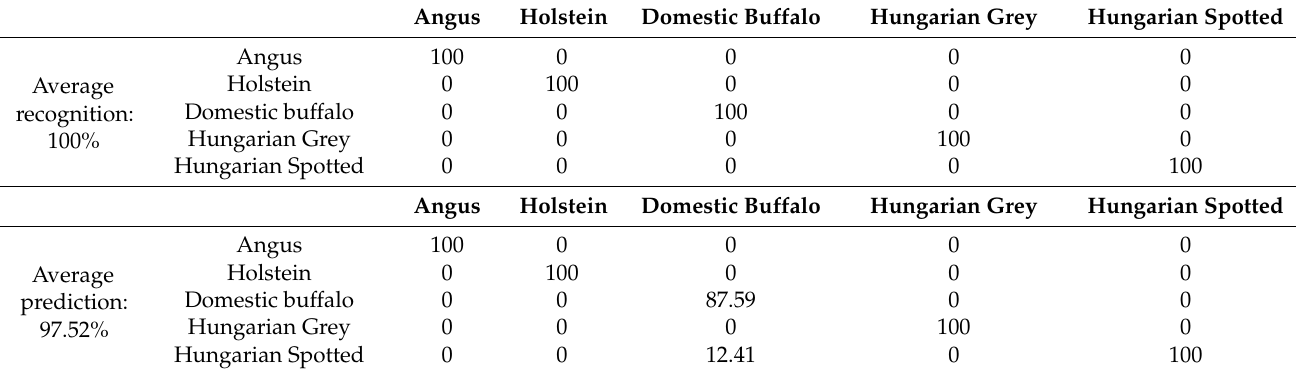
Table 1. Confusion matrix showing the classification accuracies of Angus, domestic buffalo, Holstein, Hungarian Spotted, and Hungarian Grey bovine breeds. Columns represent the actual class membership (%) and the rows represent the predicted class membership (%). Angus Holstein Domestic Buffalo Hungarian Grey Hungarian Spotted